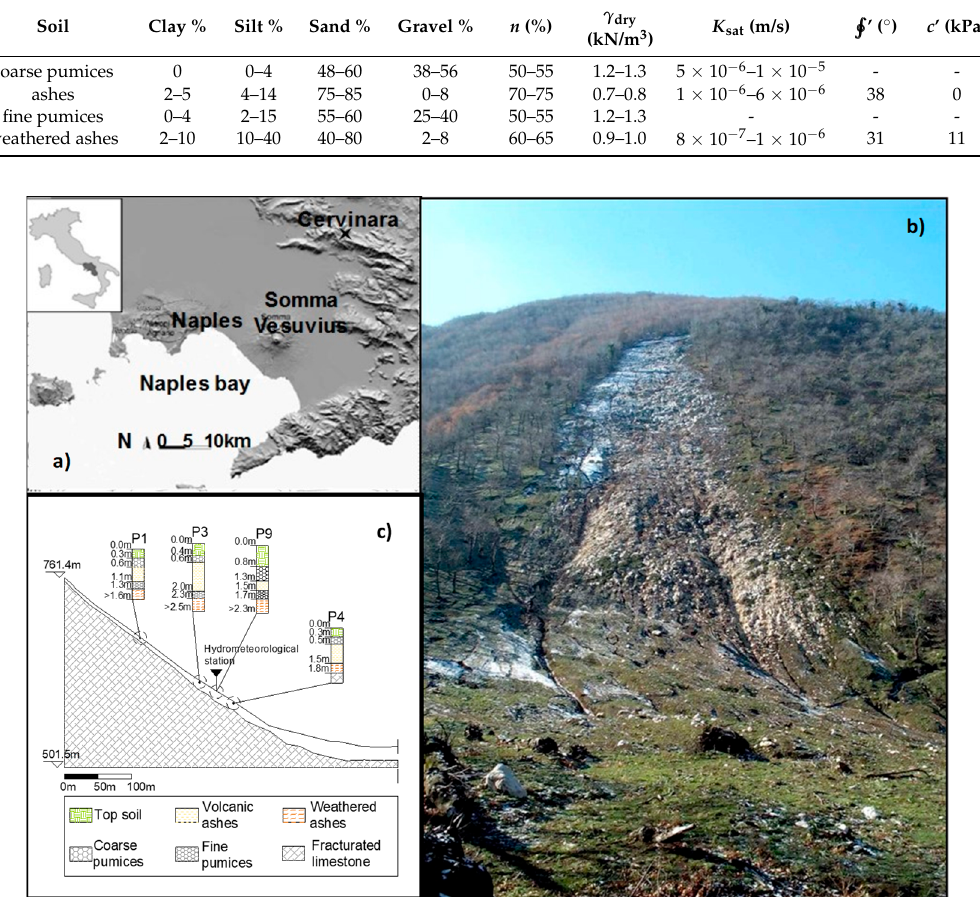
Figure 1. The slope of Cervinara: geographic location ( a ); front view of the scarp of the main landslide of 16 December 1999 ( b ); cross-section sketch with indication of the monitoring station and of the layered profile observed in four pits ( c ).